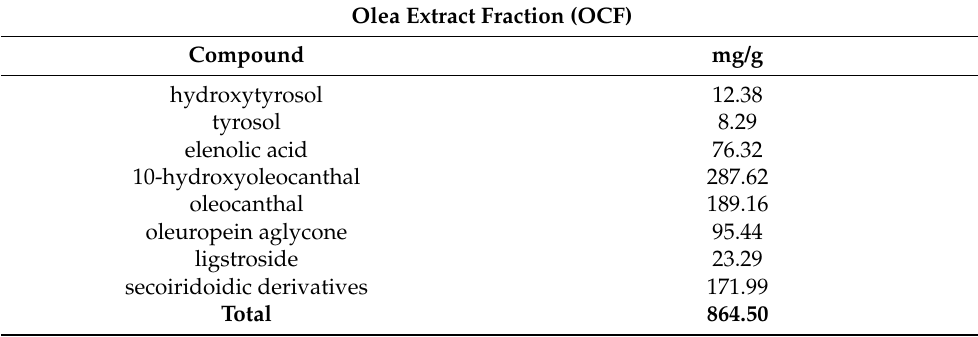
Table 1. Composition of the OCF obtained by